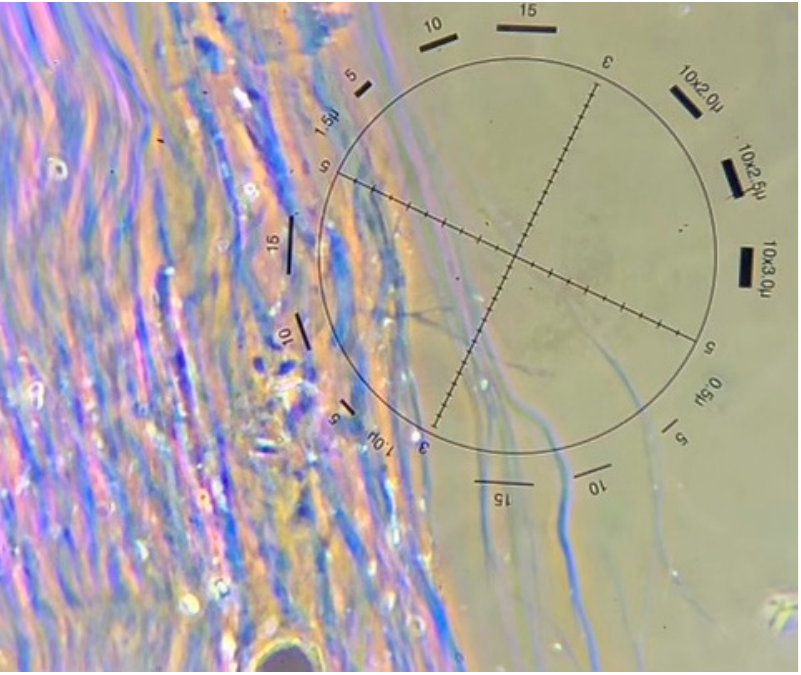
Figure 2. Chrysotile fibres from a soil sample seen with polarized light microscopy and dispersion staining (image courtesy of Focus Analytics, 2023).